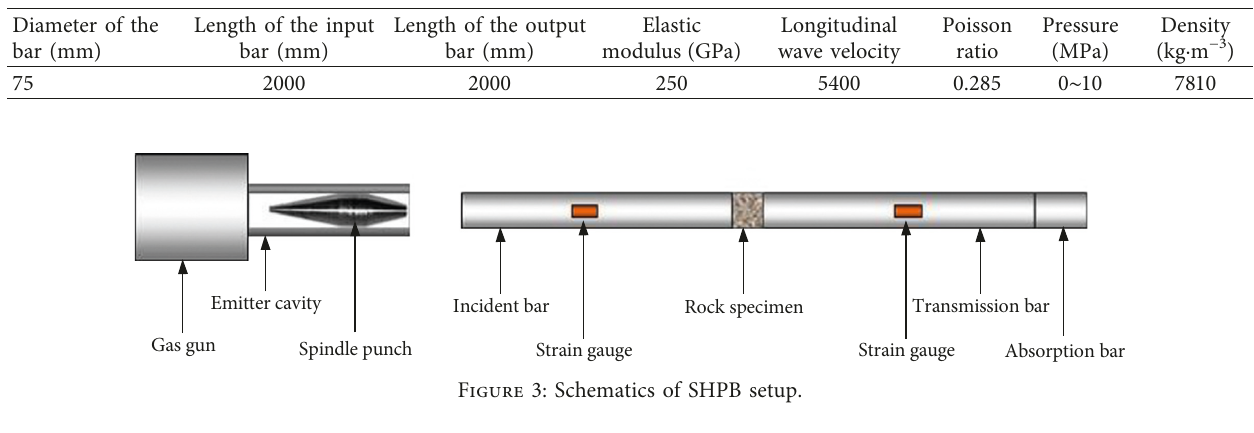
Table 2: Parameters of